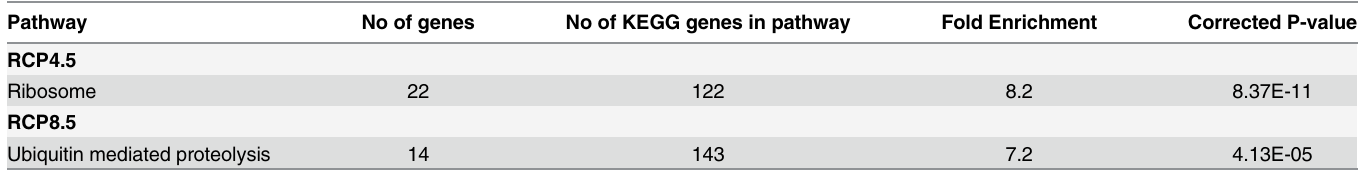
Table 3. KEGG pathway analysis. Gene enrichment analysis showing KEGG pathways involved in thermal and ocean acidification stress for Acropora millepora exposed to reduced emissions Representative Concentration Pathway (RCP4.5) and business as usual (RCP8.5) scenarios.